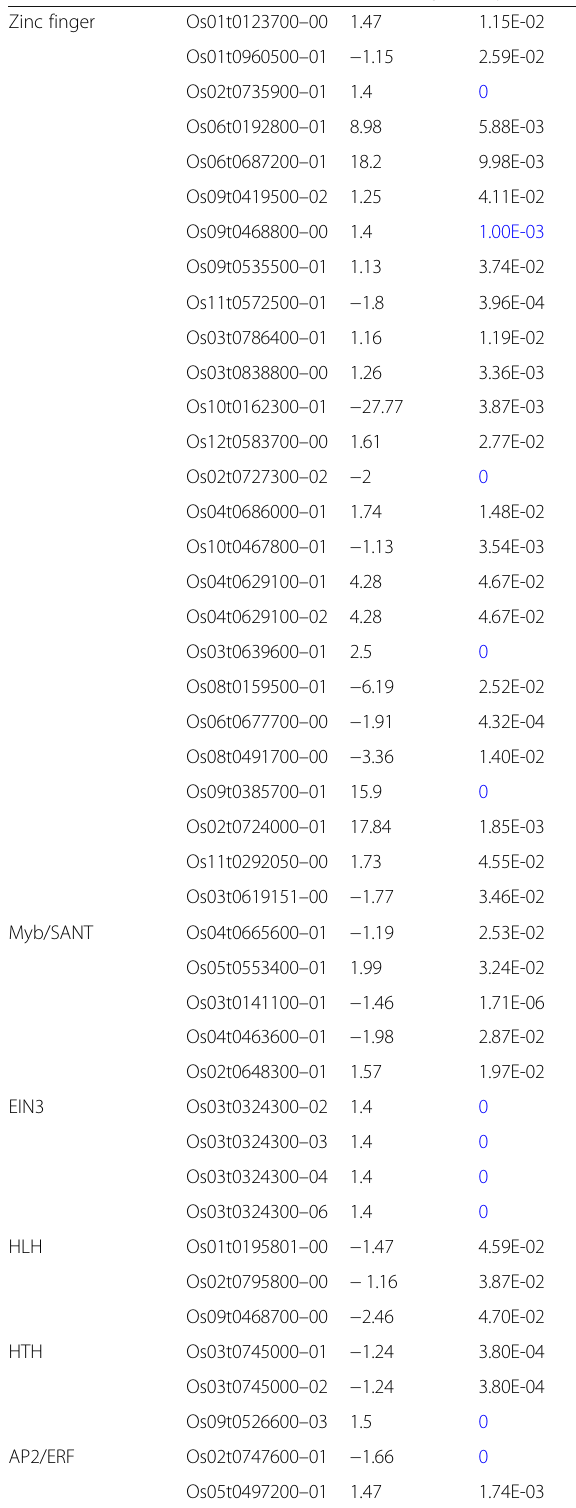
Table 2 The differentially expressed transcription factors encoded by the rice genes under the control of PIPs InterPro annotation Transcript-ID